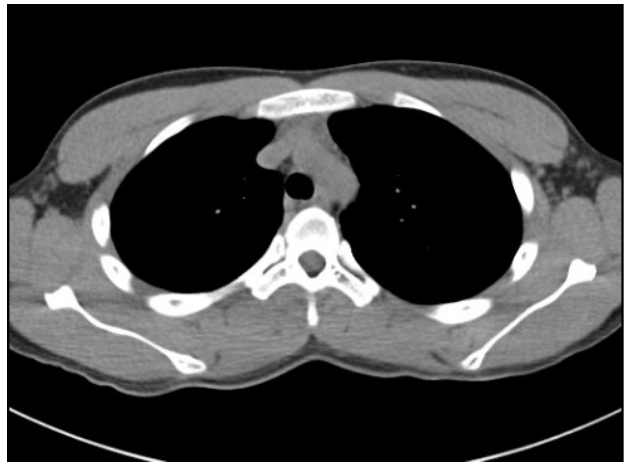
Figure 1. Chest CT taken at an outside hospital about 5 months prior to presentation demonstrates no abnormal mass lesion at the paraspinal area of the thoracic spine.